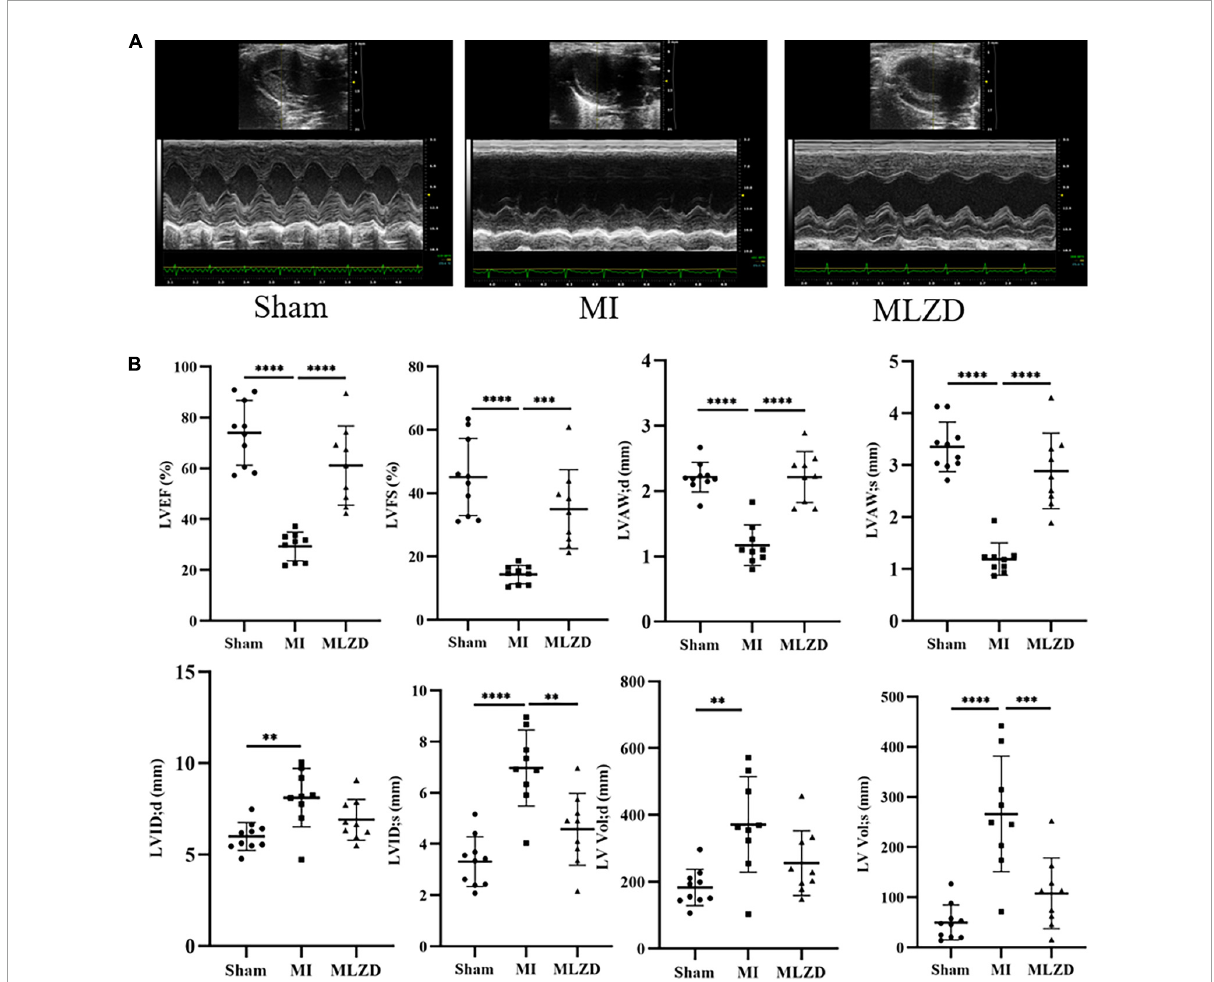
FIGURE2 Modified Linggui Zhugan Decoction (MLZD) exerted protective effects on cardiac morphological abnormalities and dysfunctions. (A) Representative images of echocardiographic measurements in three groups. (B) Quantitative analysis of cardiac structure and function via echocardiography parameters, n = 9 or 10 per group. Data are mean ± standard deviation ( x ± s); ∗∗ P < 0.01, ∗∗∗ P < 0.001, ∗∗∗∗ P <